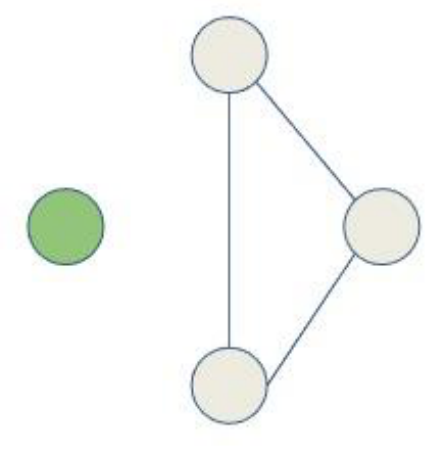
Figure 11. Visual representation of lone